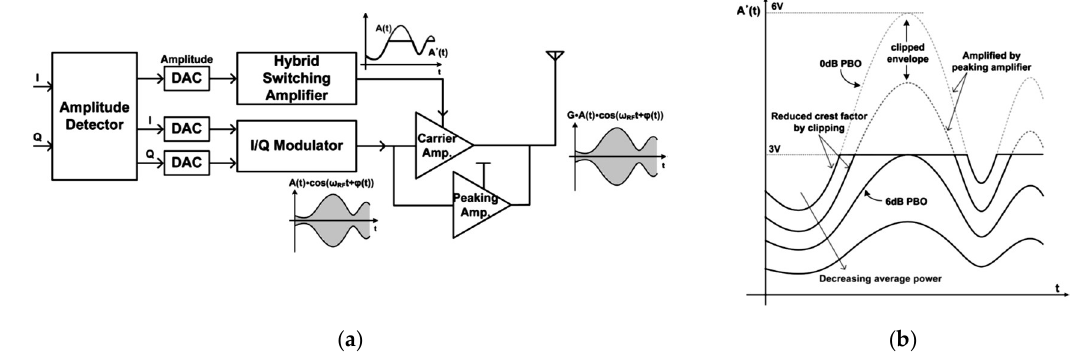
Figure 5. ( a ) Block diagram of a Doherty PA with Envelope Tracking. ( b ) Carrier PA supply voltage at different output power levels [41].